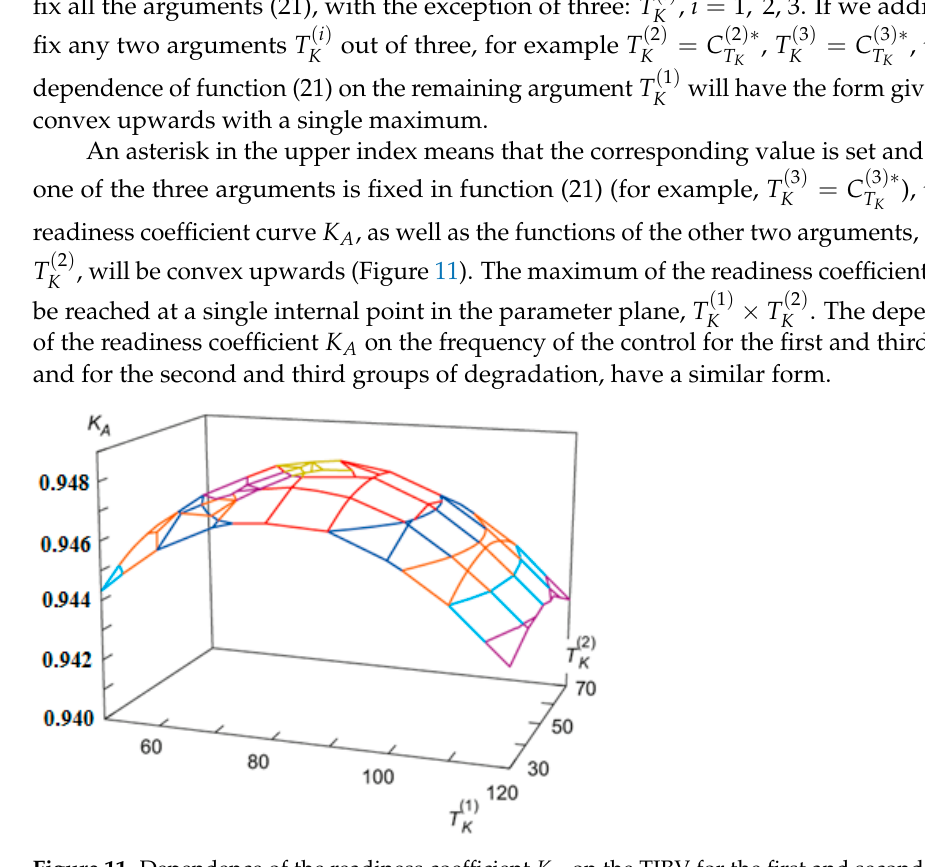
K on the TIBV for the first and second deg- A